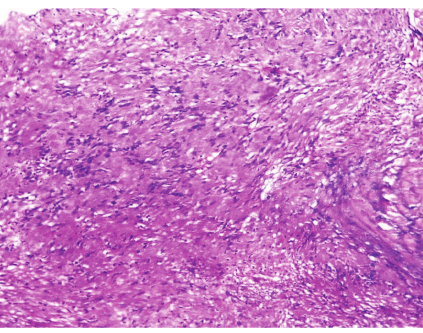
Figure 5: Spindle-shape neural cells arranged in Antoni A pattern with Verocay